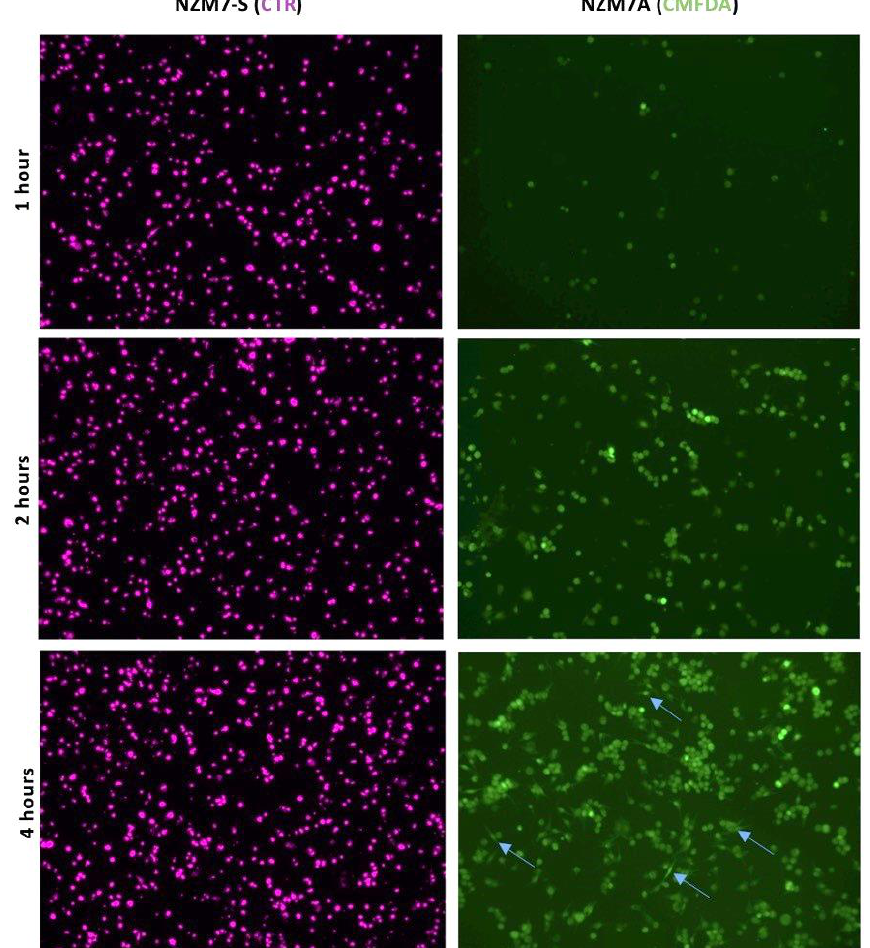
Figure 5. NZM7-S adhere to human cerebral microvascular endothelial cells at a faster rate than NZM7A cells. hCMVECs were seeded at 20,000 cells per well in three identical plates. NZM7-S and NZM7A cells were stained with live cell stains CTR and CMFDA, respectively. After the formation of a confluent monolayer of hCMVEC (endothelial cells) at approximately 48 h, the melanoma cells were added to the apical face of hCMVECs at an E:T ratio of 1:1. Blue arrows show evidence of NZM7A cells elongating at 4 h. The presence of the hCMVECs is not revealed in the respective images. Melanoma populations were co-cultured on top of the hCMVECs for 1, 2 and 4 h, at which time points non-adherent material was removed and cells fixed in PFA. Images were acquired at 10× on an EVOS microscope.